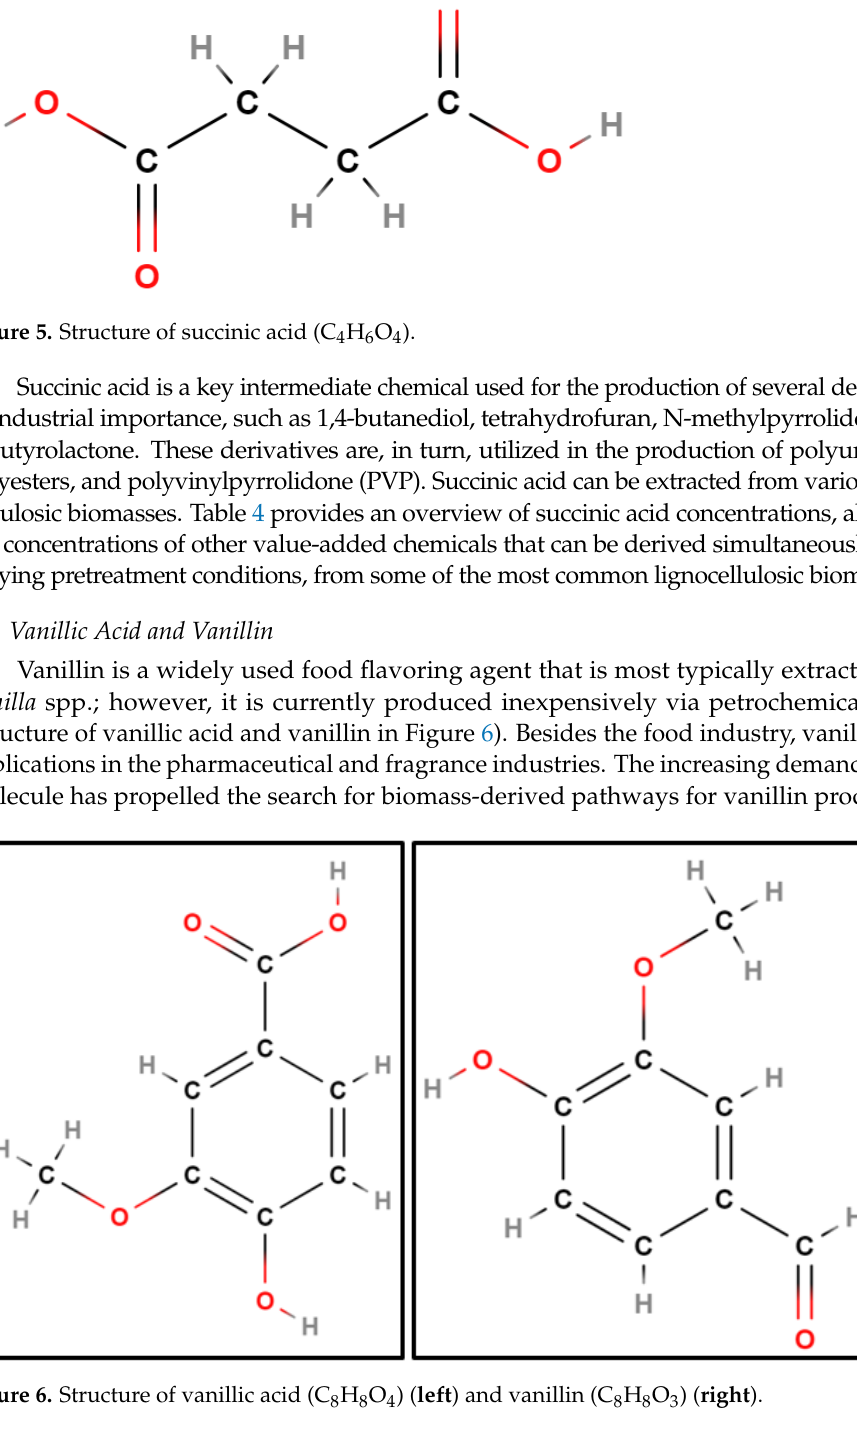
Figure 6. Structure of vanillic acid (C 8 H 8 O 4 ) (left) and vanillin (C 8 H 8 O 3 ) (right) . Vanillin can be extracted from lignin, ferulic acid, glucose, vanillic acid, aromatic amino acids, isoeugenol, waste residue, and other substrates [72]. Currently, Borregaard (Sarpsborg,